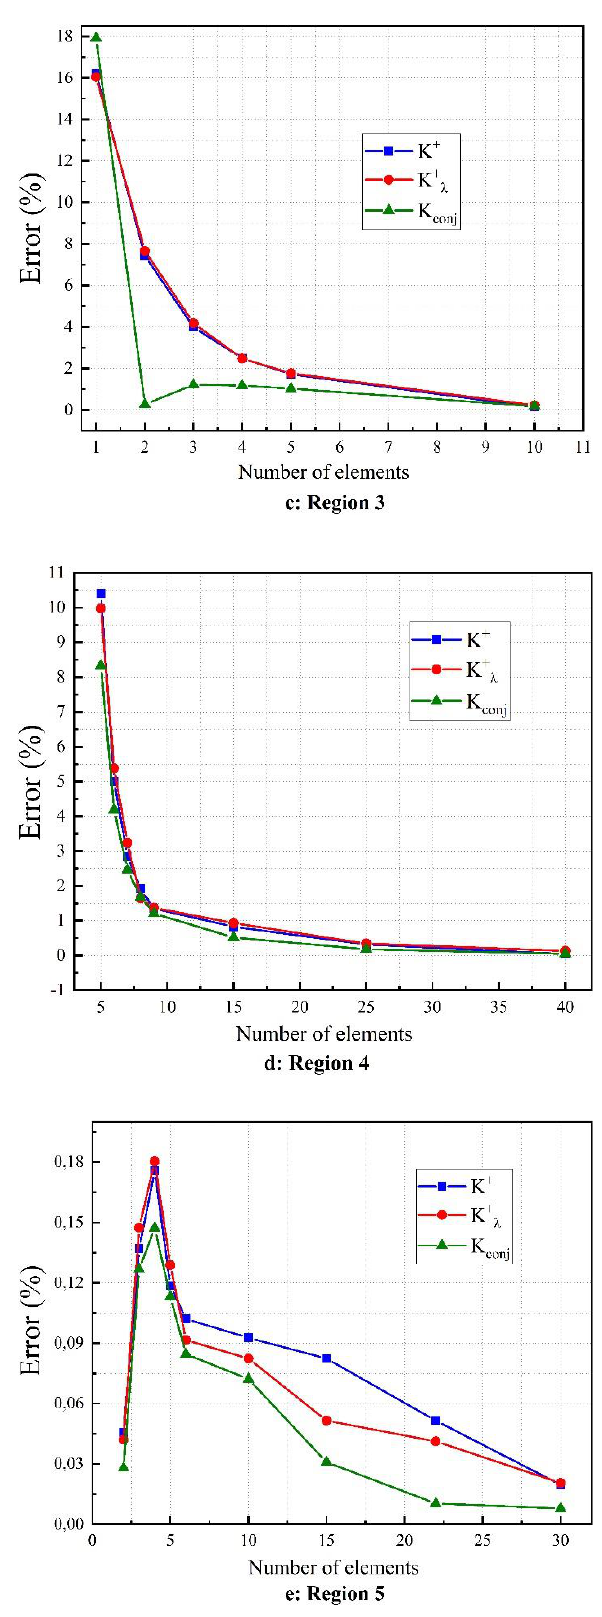
Figure 5. ( a – e ): The graphical representation of obtained errors for P 7 and approximation for various sets of elements and different regions.